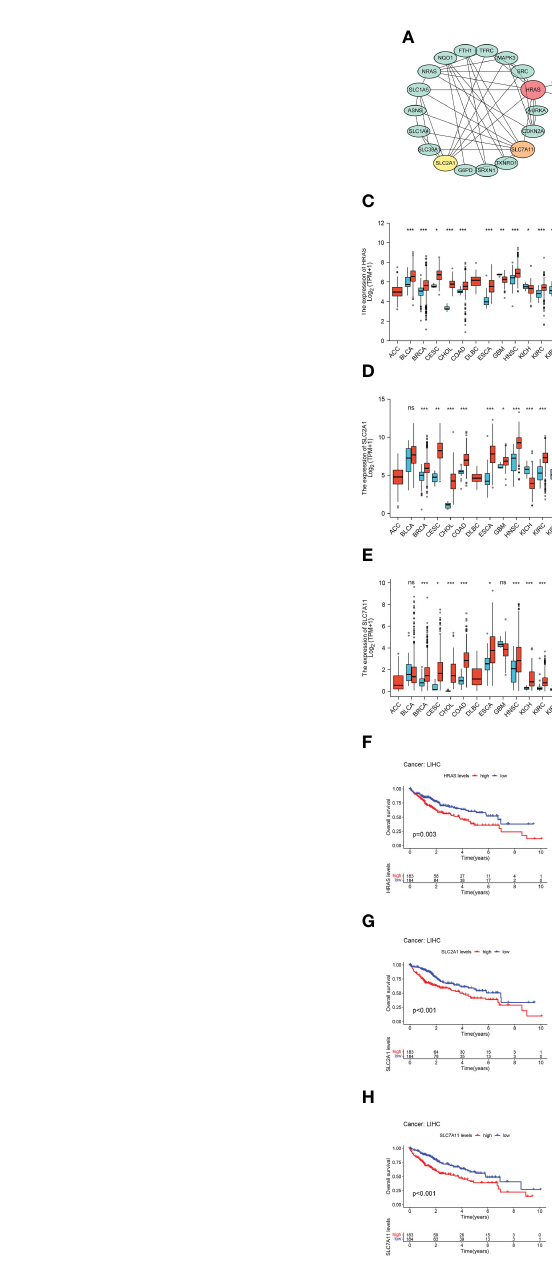
FIGURE 2 Hub Gene Screening and Pan-carcinoma Analysis. (A) Identi fi ed PPI hub genes. (B) Differential expression of HRAS, SLC2A1, and SLC7A11 in HCC paired samples. (C) Differential expression of HRAS in 33 cancers. ns, not signi fi cant; *p<0.05; **p<0.01; ***p<0.001. (D) Differential expression of SLC2A1 in 33 cancers. ns: not signi fi cant; *p<0.05; **p<0.01; ***p<0.001. (E) Differential expression of SLC7A11 in 33 cancers. ns: not signi fi cant; *p<0.05; **p<0.01; ***p<0.001. (F) Kaplan-Meier survival curve of HRAS and pan-carcinoma Univariate Cox regression analysis. (G) Kaplan-Meier survival curve of SLC2A1 and pan-carcinoma Univariate Cox regression analysis. (H) Kaplan-Meier survival curve of SLC7A11 and pan-carcinoma Univariate Cox regression